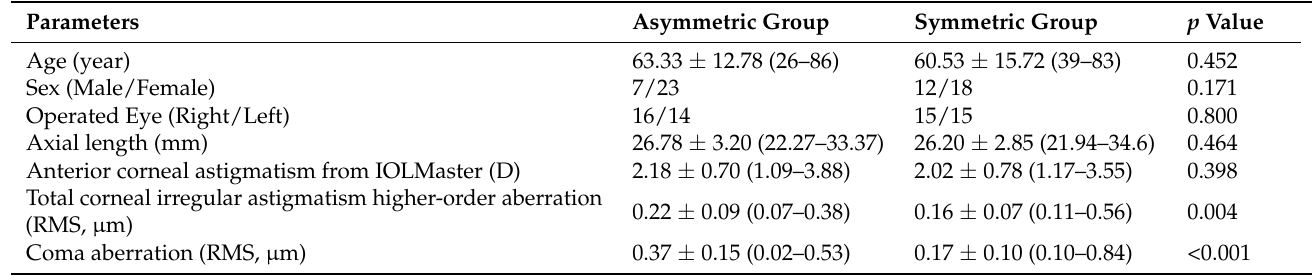
Table 1. Characteristics of patients in the asymmetric and symmetric bowtie corneal astigmatism